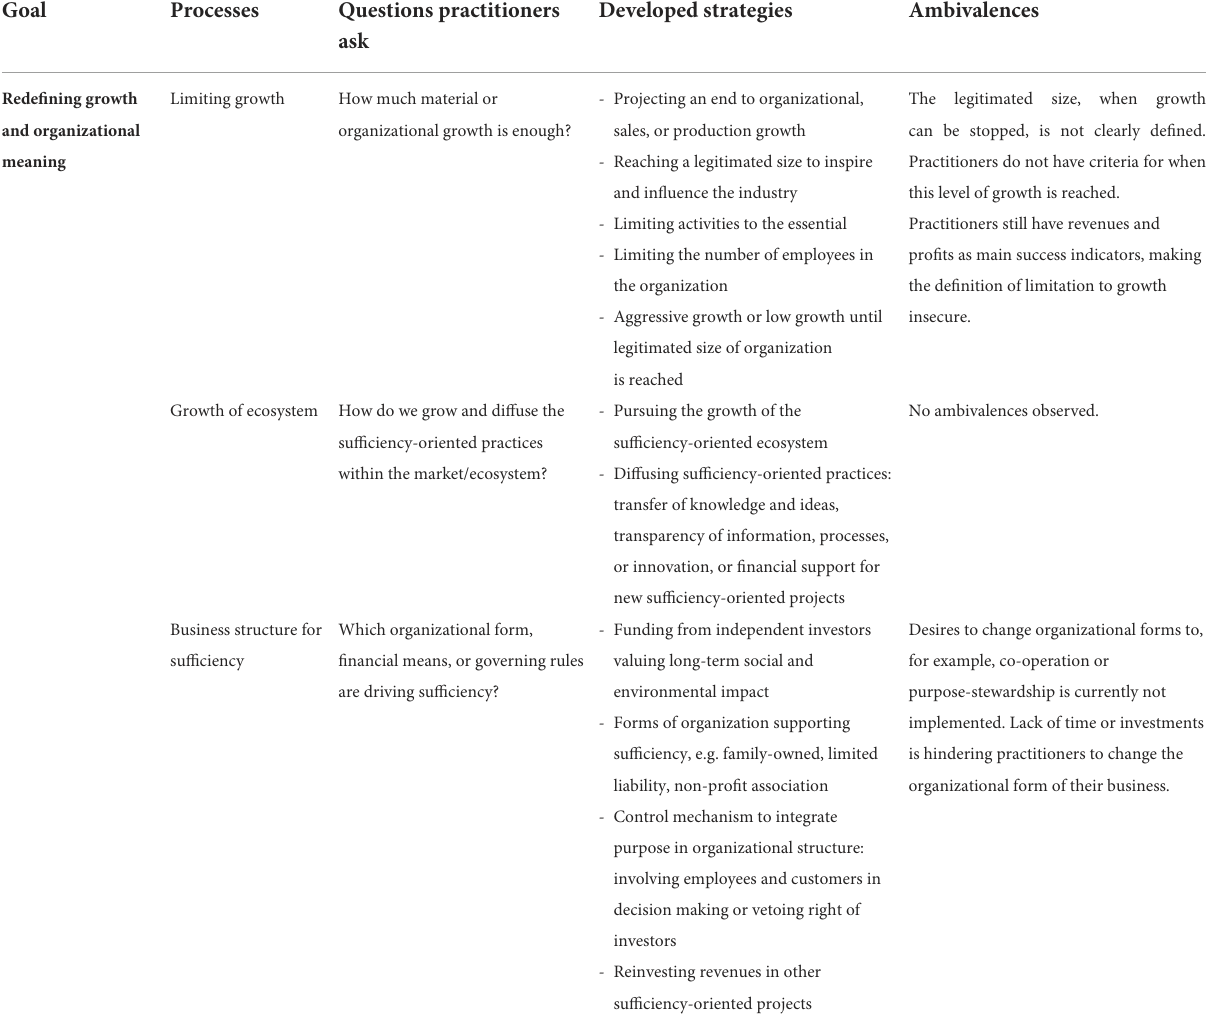
TABLE 7 “Rethinking social meaning of the own organization”: Relevant questions, strategies, and emerging